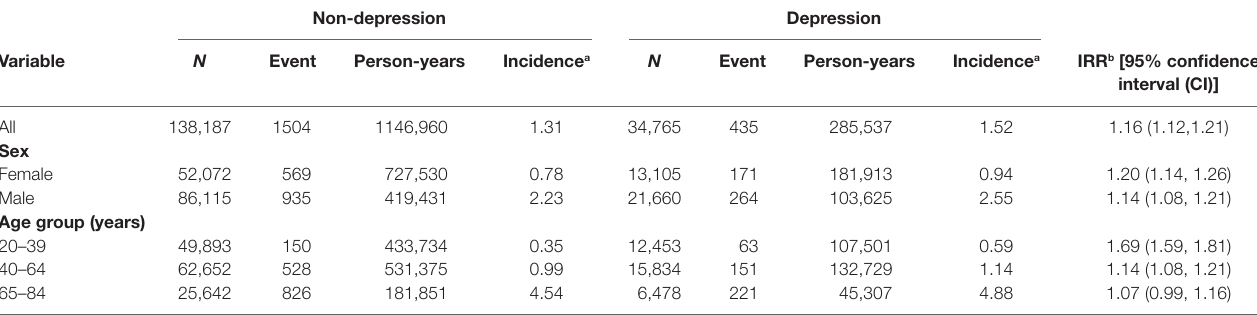
TaBle 2 | Incidence of pulmonary tuberculosis estimated by sex and age between depression group and non-depression